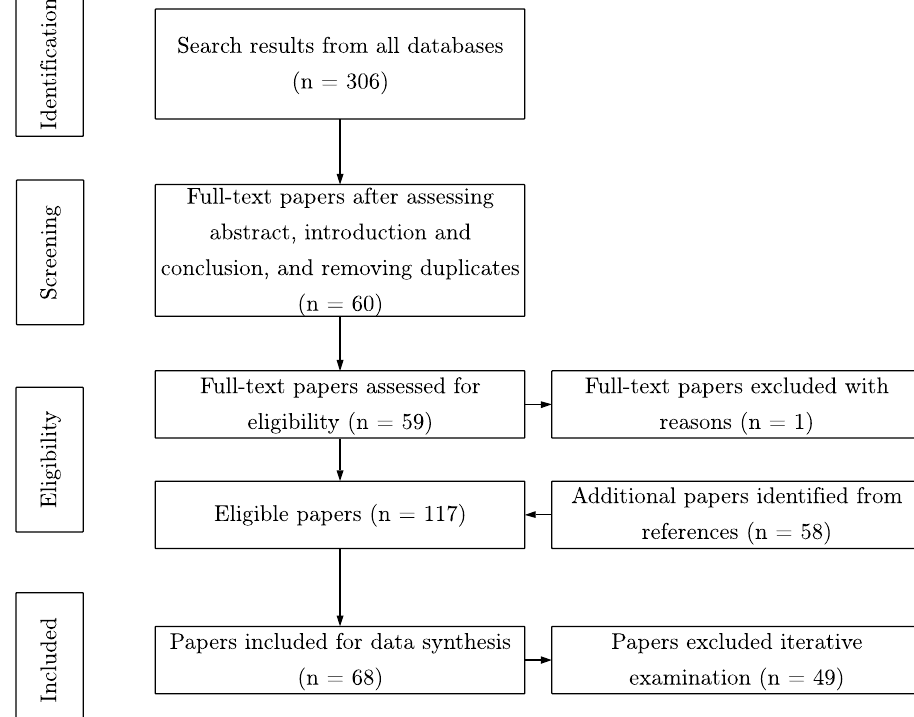
Figure 2. Summary of the search